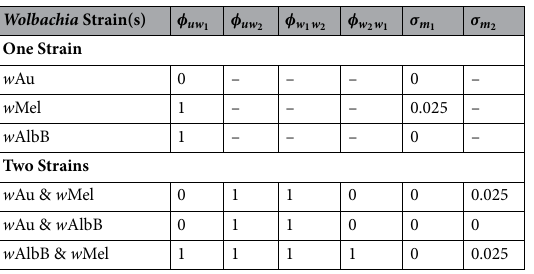
Table 3. Table showing the parameter values used for the effect of CI and LWI on seasonal variation for one and two Wolbachia